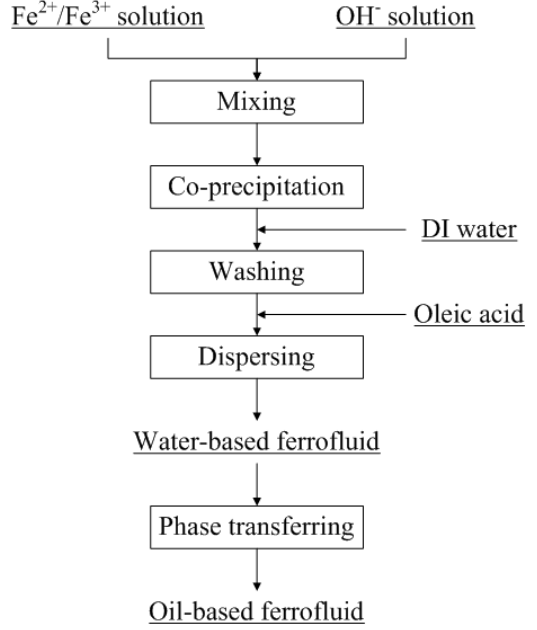
Figure 1. The flow chart of the precipitation procedure.